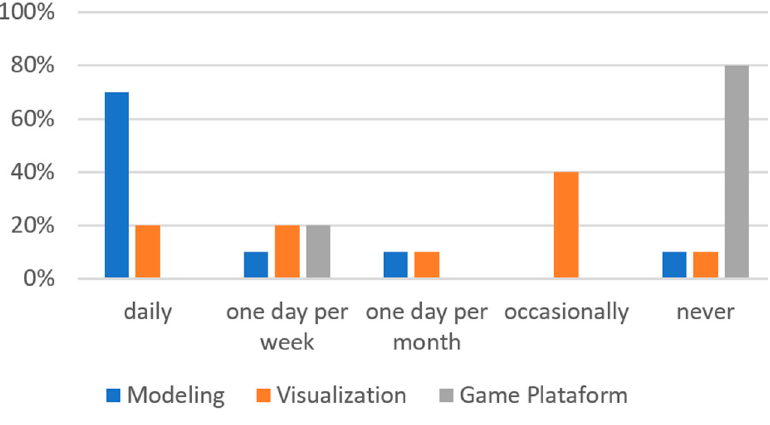
Figure 3. Use frequency of 3D platform.